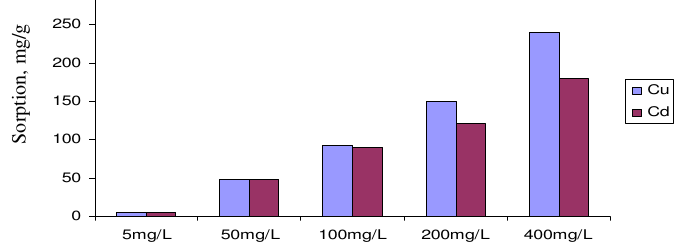
Figure 5. Comparison of maximum sorption of Cu 2+ and Cd 2+ at different initial